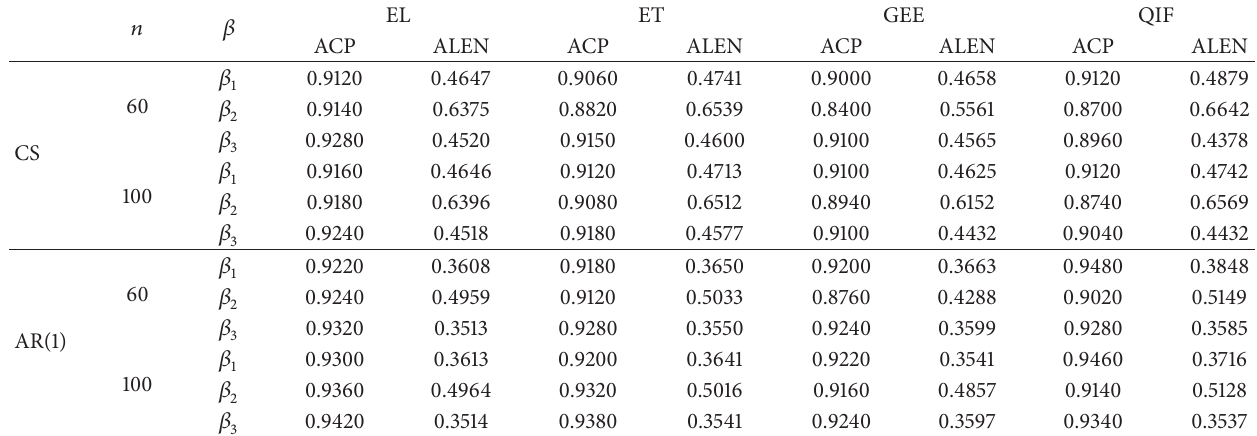
Table 1: The average coverage probabilities (ACP) and the average lengths (ALEN) of the confidence intervals for 𝛽 1 , 𝛽 2 , and 𝛽 3 when the nominal level is 0.95 and the true correlation structure is AR(1)